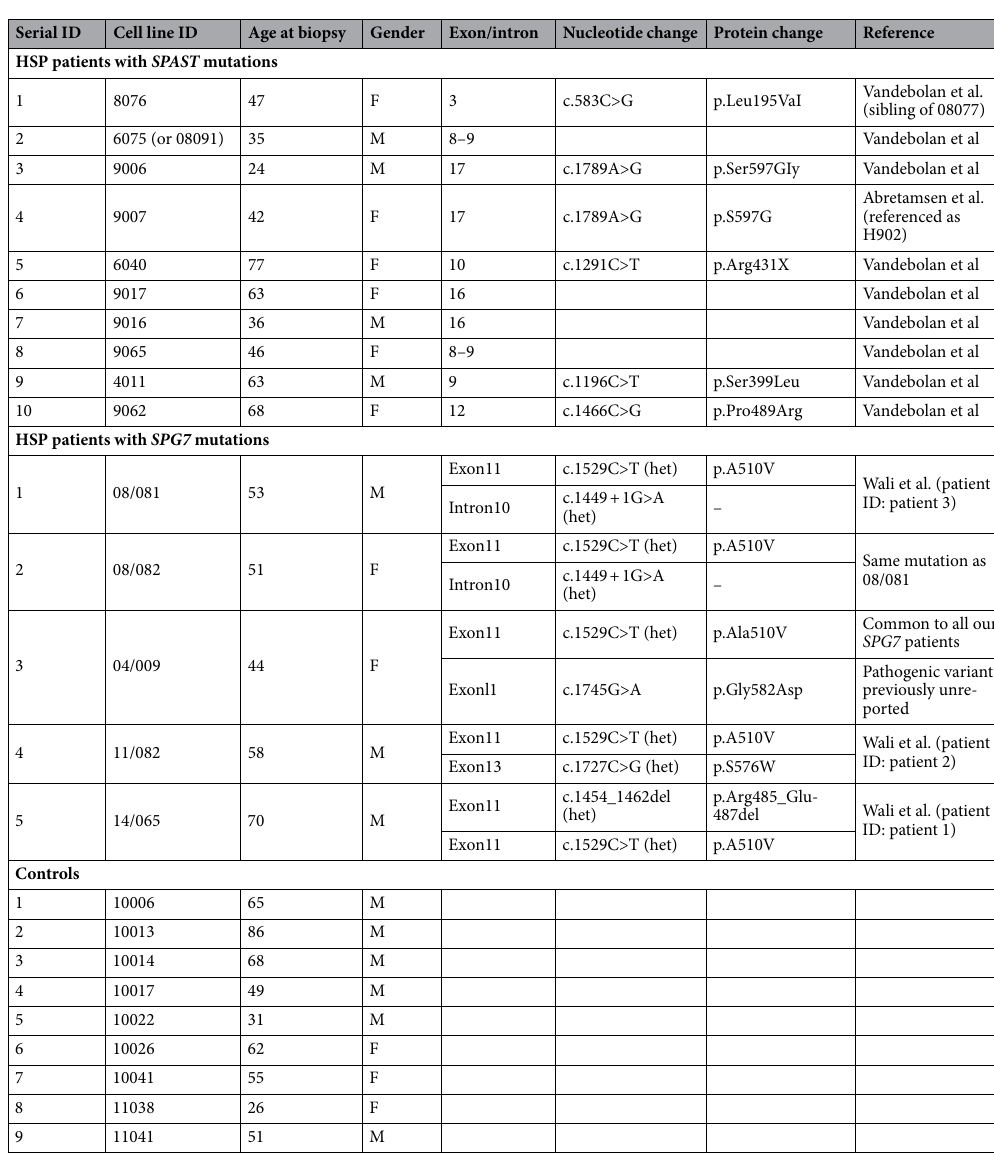
Table 1. Mutation details of HSP patients with SPG7 and SPAST mutations. Vandebona et al. (PMID: 23252998), Abrehamsen et al. (PMID: 23264559) and Wali et al. (PMID: